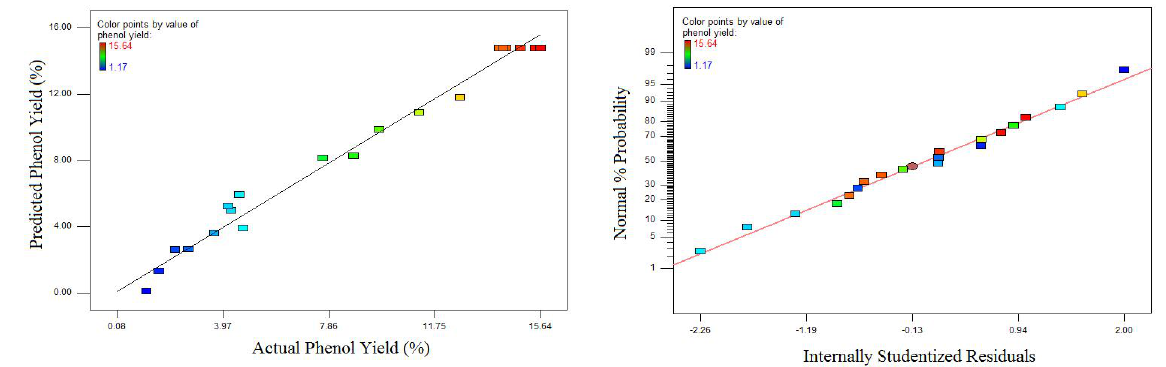
Fig. 4. Plot of actual vs. predicted values of phenol yield. Fig. 5. Normal probability plot of